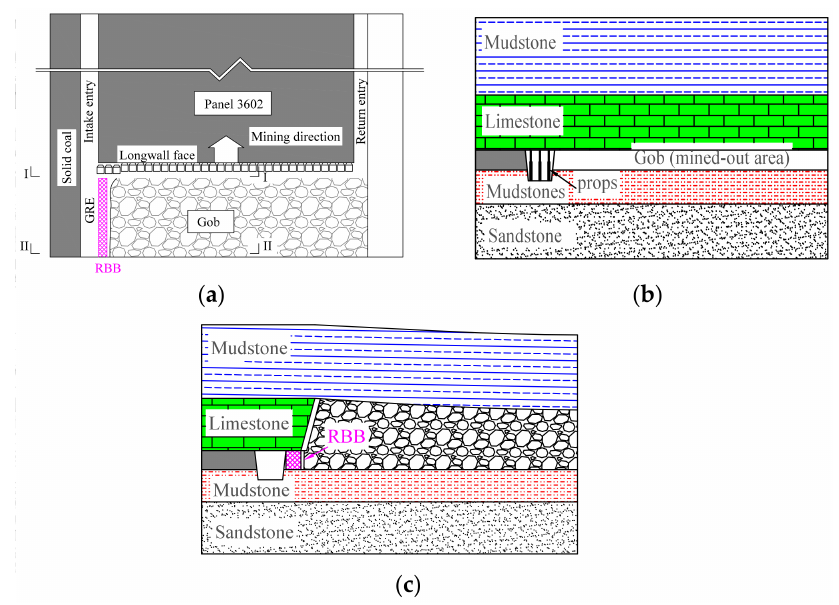
Figure 1. Schematic diagram of Gob-side entry retaining-thin coal seam-limestone roof (GER-TCS-LR): ( a ) Plan view; ( b ) I-I section and ( c ) II-II